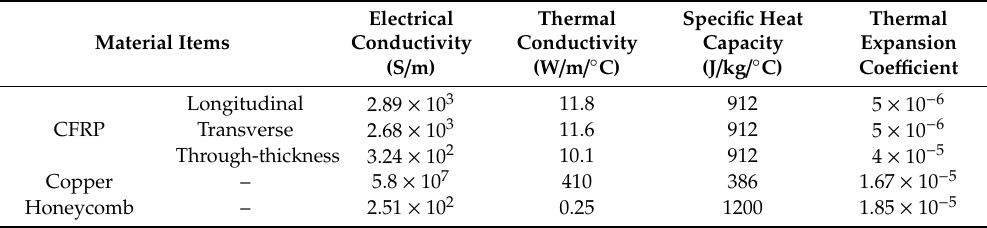
Table 2. Electrical and thermal properties of applied material at 25 °C.